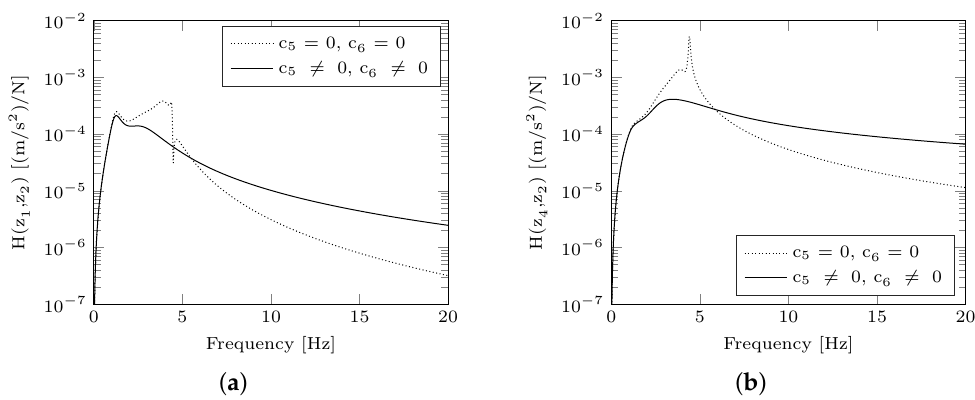
Figure 8. Inertance of a 6-DoFs tractor for a force acting along the vertical direction on the CoG of the tractor frame z 2 . ( a ) The response measured on the operator’s seat z 1 ; ( b ) the response measured on the CoG of the cabin z 4 .